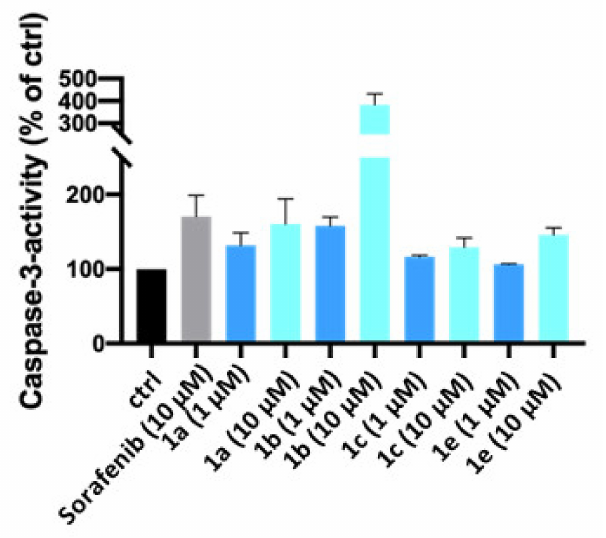
Figure 4. Induction of apoptotic caspase-3 activity. Treatment with 1a , 1b , 1c , 1e and sorafenib for 24 h dose-dependently induced caspase-3 activity of HepG2 cells. Data of n = 3 experiments are shown as means ± SD of percentage increase as compared to untreated